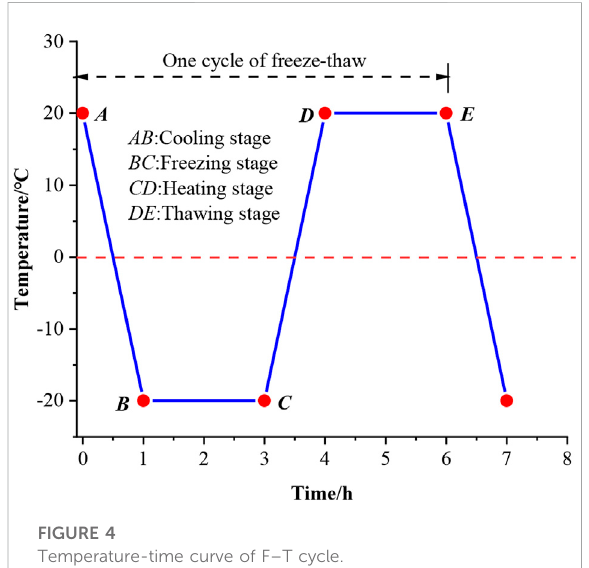
FIGURE 4 Temperature-time curve of F – T cycle.